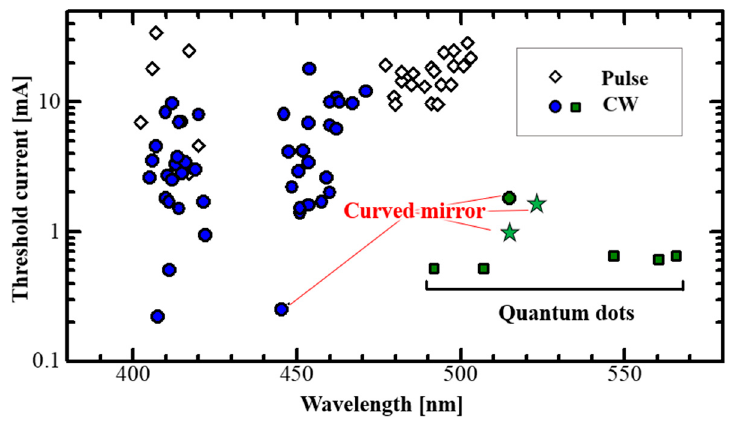
Figure 8. Plot to show how the threshold current of GaN-based VCSELs depends on the wavelength. This is based on Hatakoshi’ s plot [4,37] and redrawn by the present author adding new plots that appears as